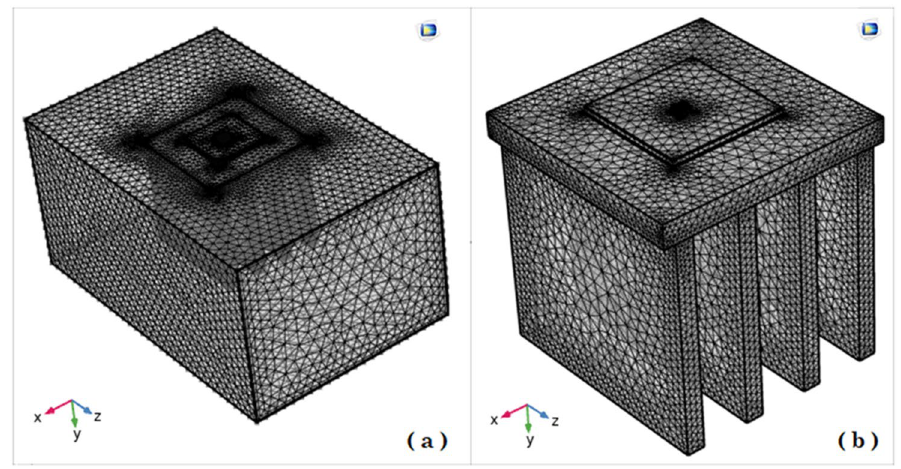
Figure 2. Mesh generated in the domain and LED finned section (COMSOL Multiphysics 5.6, https:// www. comsol.